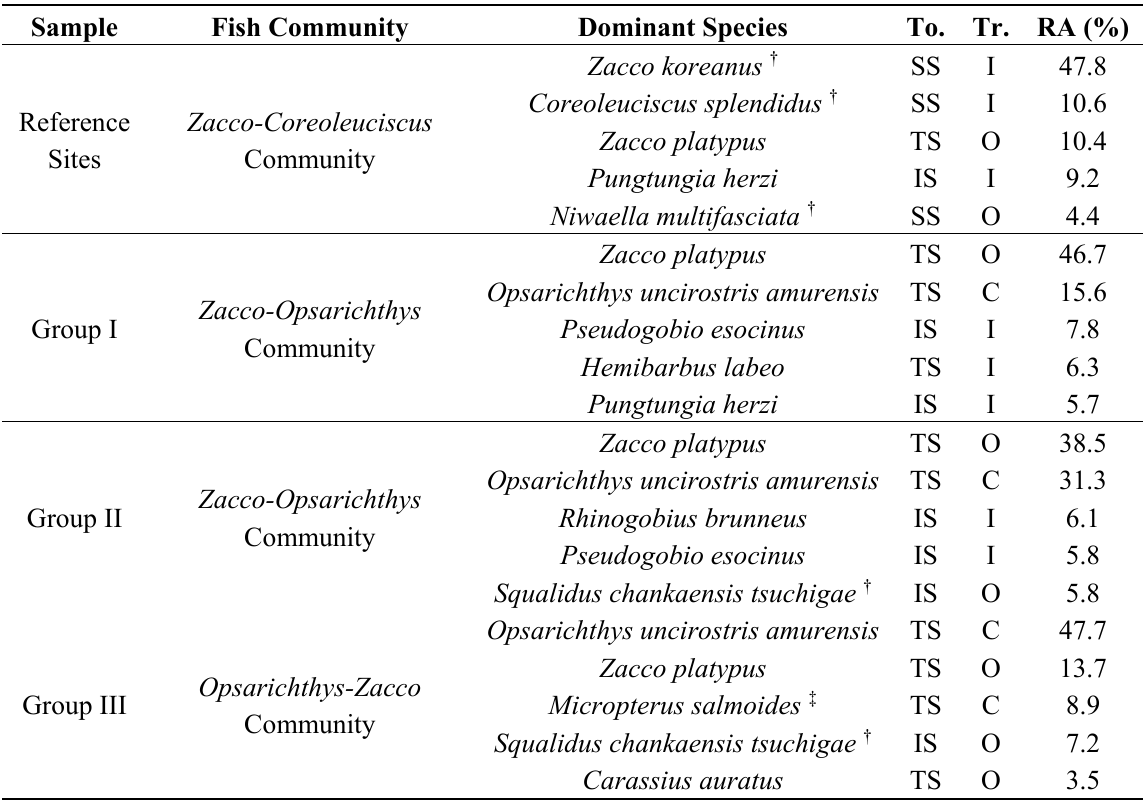
Table 5. Fish fauna and dominant species for collected fish population in Nakdong River.